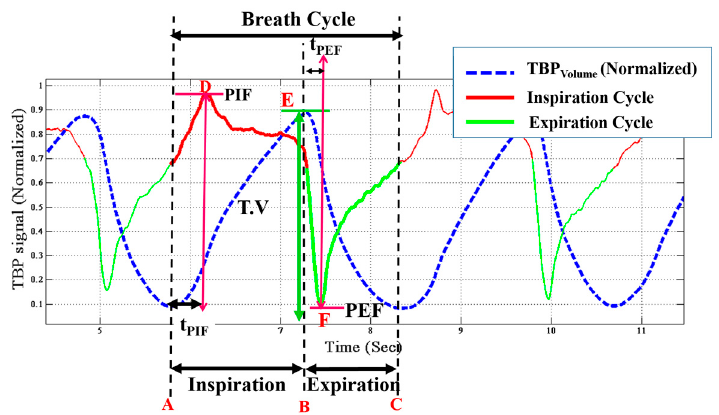
Figure 8. Tidal breathing pattern signal with respiratory parameters annotated. PIF: peak inspiratory flow; PEF: peak expiratory flow; t PEF : Time to peak expiratory flow; t PIF : peak inspiratory flow. To derive the respiratory parameters, it is essential to detect the onset and end of inspirations and expirations [15]. The inspiration cycle is from the minima to the maxima while the expiration cycle is from the maxima to the next minima of the same TBP volume . Corresponding to Figure 8, A–C is a breathing cycle, where A–B is the inspiratory cycle and B–C is the expiratory cycle. A number of independent and dependent attributes of respiratory signals are computed from the TBP volume and TBP flow signals. These parameters [13,17–19,21,23,25] are described below with reference to Figure 8: Inspiratory time (TI) is the time elapsed from onset (A) to the end (B) of inspiration. It is given in seconds .